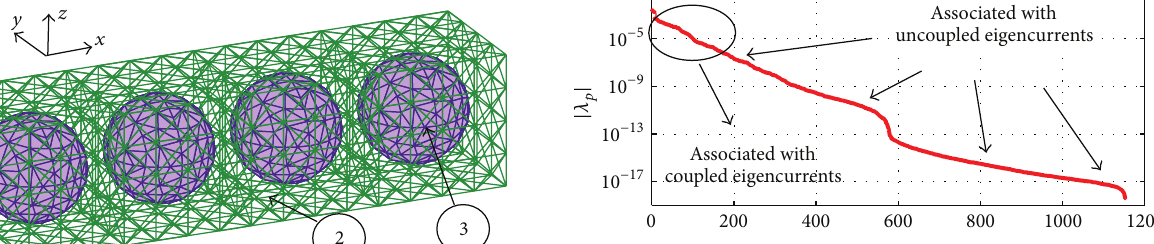
Figure 7: For convergence study, eigenvalues of [𝑆 𝑘𝑘 ] , 𝑘 = 1, ...,4 , asafunctionoftheirindex 𝑝 = 1, ...,2𝑁 𝐹 forthebricksofthemodel in Figure 5 at 𝑓 =